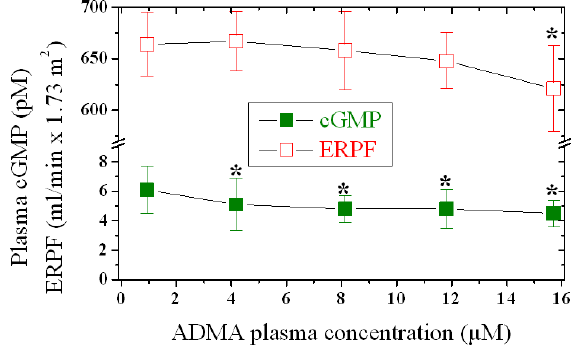
Figure 3. Effects of intravenously administered ADMA at infusion rates of 0.0, 12.5, 25, 37.5, and 75 μ g/kg/min in six healthy volunteers on plasma cGMP levels and ERPF. The corresponding ADMA peak plasma concentrations were 0.94 ± 0.26, 4.17 ± 0.99, 8.13 ± 2.08, 11.8 ± 2.53, and 15.7 ± 4.29 μ M. Data are shown as mean ± SD. Asterisks indicate statistical signi fi cance ( P < 0.05) between post-infusion and pre-infusion values. This fi gure was constructed using data reported previously by our group (26).